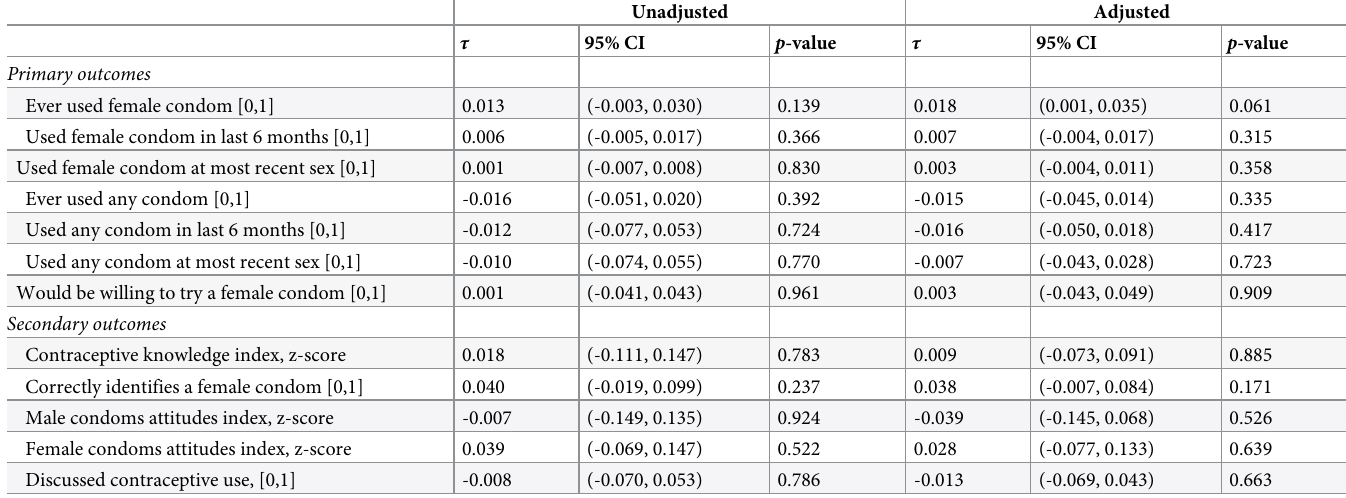
Table 3. Intention to Treat (ITT) effects of IPC Intervention on Primary Outcomes (unadjusted and adjusted).